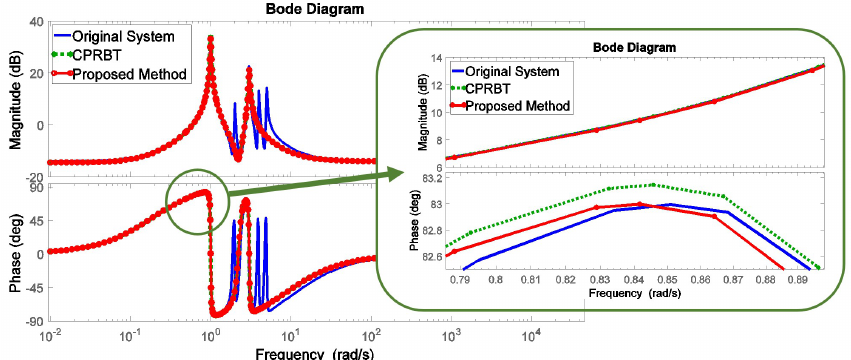
Figure 2. The bode diagrams of the original system, the CPRBT reduced model, and the proposed reduced model in Example